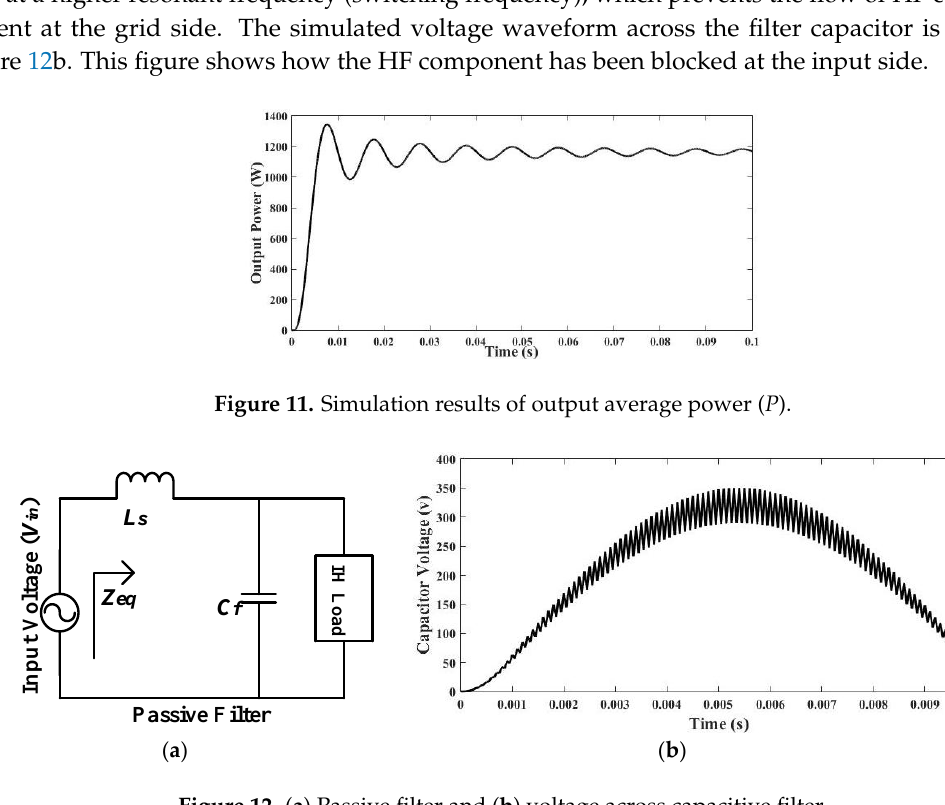
Figure 10. ( a ) Simulated waveform of output voltage ( V out ) and ( b ) simulated waveform of output current ( I out ) as a resonant converter for IH application.